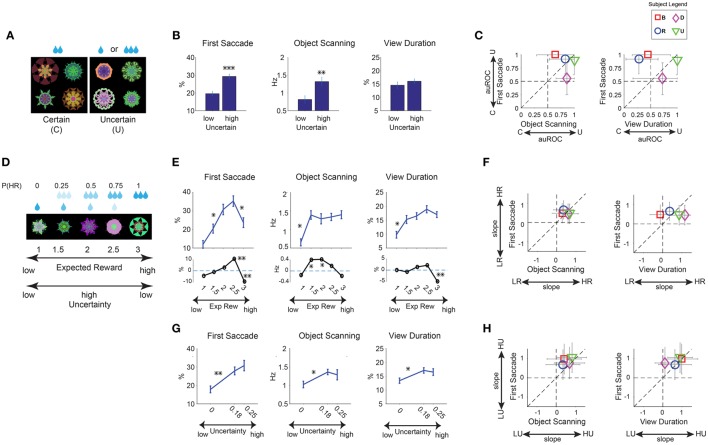
Positive learned salience of appetitive objects: reward uncertainty. (A–C) Same format as in Figures 3A–C for effects of reward uncertainty. (n = 24 viewing sessions). (D) Example set of 5 objects which were associated with a linear gradient of large reward probability, P(HR). (E) Three measures of gaze bias were averaged separately for the 5 different levels of reward probability (top plot). The statistical difference between reward probabilities (hsd post-hoc) are marked for significance (n = 24 viewing sessions). Subtraction of gaze bias in reward amount sets from reward probability (bottom plot, black lines) shows enhancement of salience by uncertainty for midlevel reward probabilities (significant differences from zero are marked). (F) Same format as Figure 3F but showing gaze bias slope as a function of reward probability for individual subjects. (G) Same format as (E) top but when objects were grouped by 3 different levels of reward variance (P(HR) = [0,1] with 0, P(HR) = [0.25,0.75] with 0.18 and P(HR) = 0.5 with 0.25 reward variance). The statistical differences between reward variances (hsd post-hoc) are marked for significance. (H) Same format as (F) but showing gaze bias slope for uncertainty levels for individual subjects. *p < 0.05, **p < 0.01, ***p < 0.001.